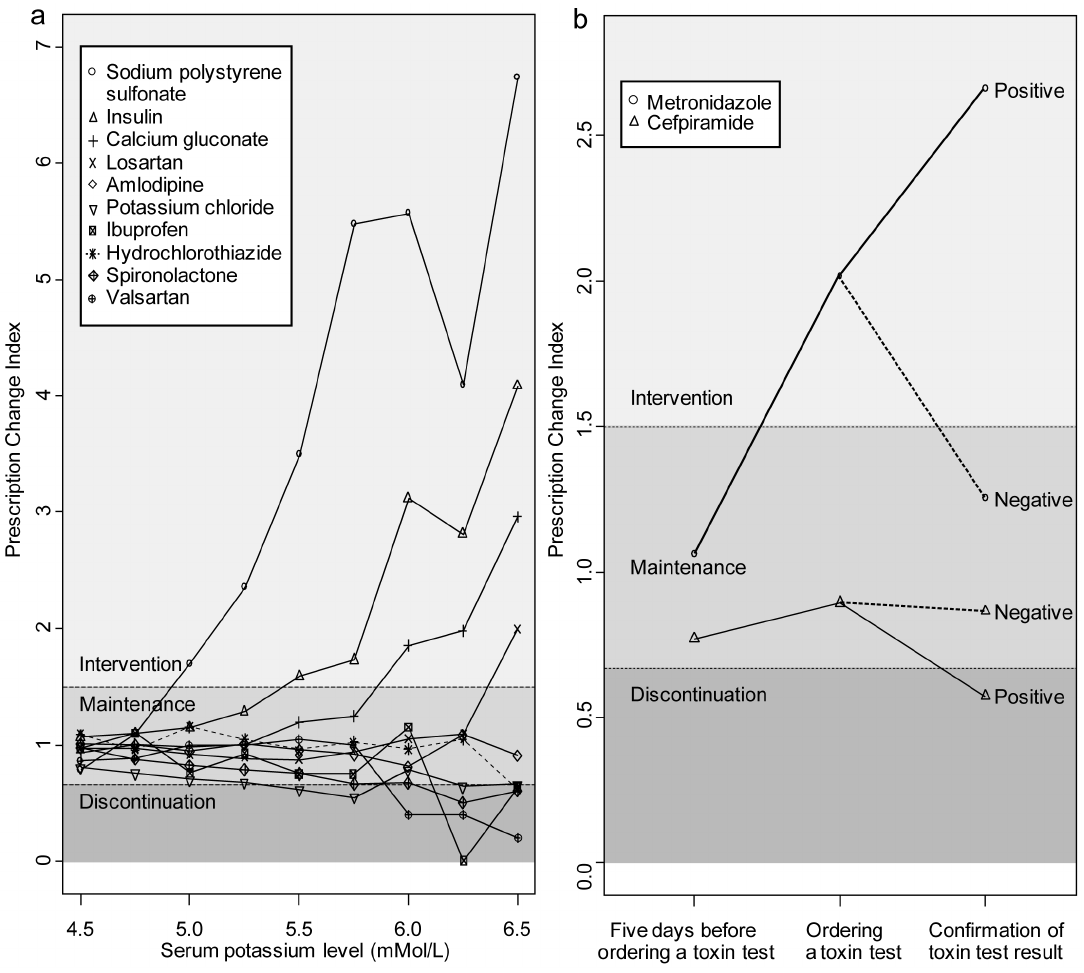
Figure 4. Graphs of prescription pattern according to event severity and clinical condition. (a): Changes in the prescription change index (PCI) according to serum potassium level. Prescriptions for sodium polystyrene sulfonate, insulin, and calcium gluconate increased with increasing serum potassium level. In contrast, use of ibuprofen, potassium chloride, spironolactone, and valsartan decreased. (b): Changes in PCI according to clinical condition. Metronidazole was used to treat Clostridium difficile -associated diarrhea (CDAD) beginning when the C. difficile toxin test was ordered by the prescriber. However, if the test was negative, use of metronidazole decreased. In contrast, if the result was positive, then cefpiramide prescription exhibited the discontinuation pattern.